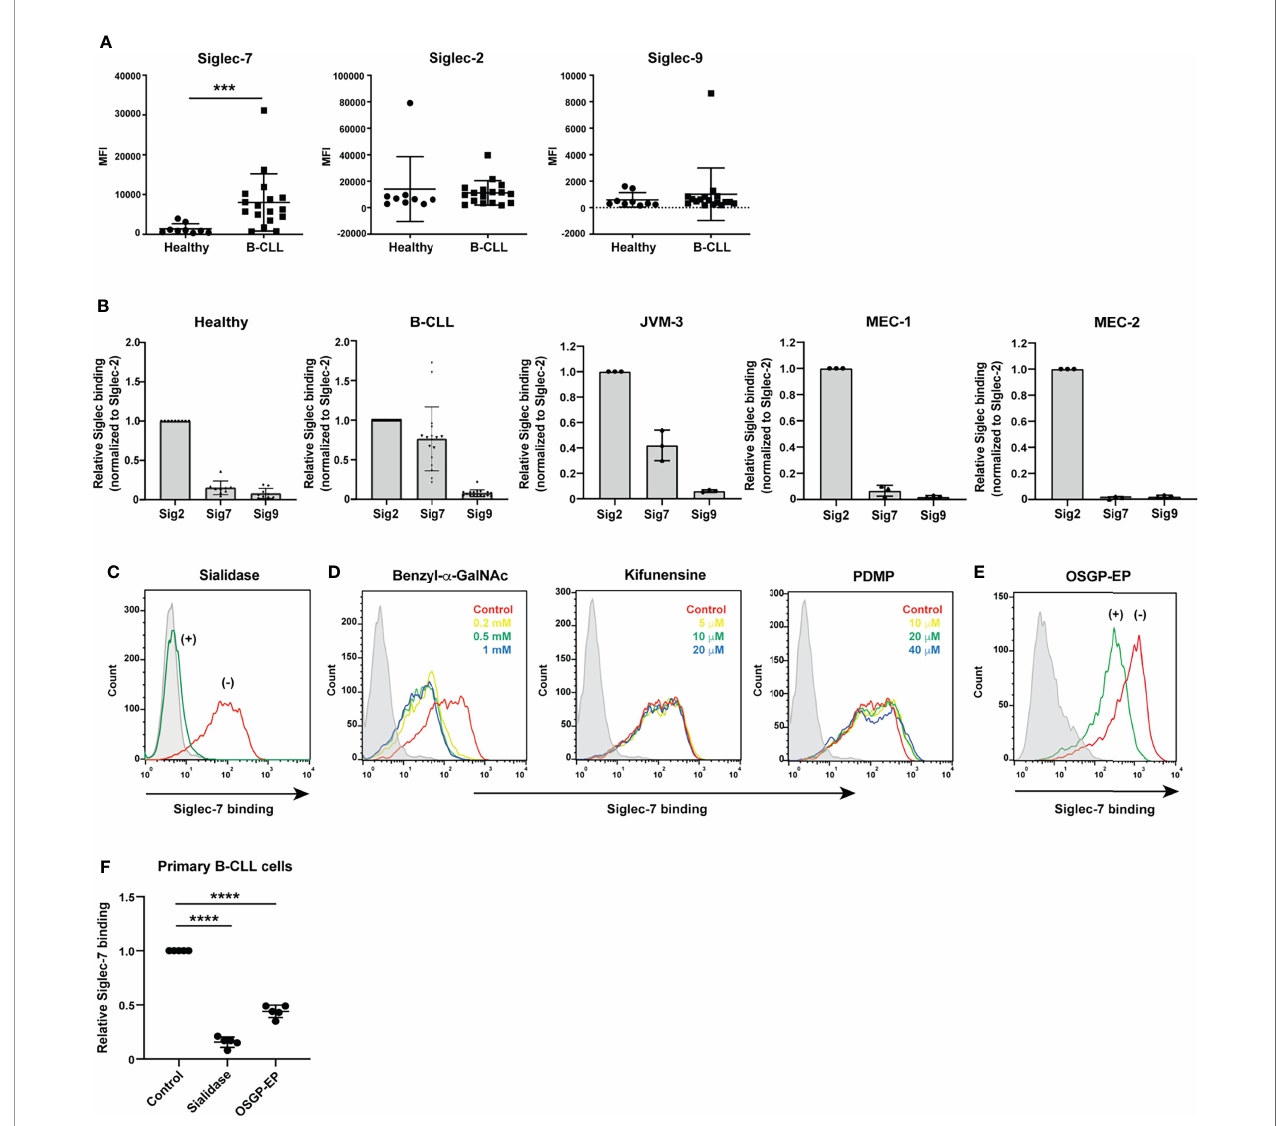
FIGURE 1 | Siglec-7 ligands are highly expressed on B cells from patients with chronic lymphocytic leukemia (CLL). (A) Comparison of Siglec ligand levels between B cells from healthy donors and those from CLL patients. The difference in Siglec-7 – Fc binding (expressed as median fl uorescence intensity [MFI]) to B cells between healthy donors (n = 9) and CLL patients (n = 17) was statistically signi fi cant (*** P < 0.001, Mann – Whitney test), whereas the difference in CD22/ Siglec-2 – Fc and Siglec-9 – Fc binding between the two groups was not ( P = 0.33 and 0.38, respectively; Mann – Whitney test). Bars represent mean ± SD. (B) Siglec ligands in primary B cells and CLL B cell lines. JVM-3, MEC-1, and MEC-2 cells were stained with recombinant CD22/Siglec-2 – Fc, Siglec-7 – Fc, and Siglec-9 – Fc and analyzed with fl ow cytometry. Siglec – Fc binding signals (in MFI) were normalized to that of CD22/Siglec-2 – Fc. Bars represent mean ± SD of three independent experiments. For primary B cells, the data was normalized individually for each donor [healthy donors (n = 9) and CLL patients (n = 17)], using the same dataset as presented in panel (A) . JVM-3 most closely resembled CLL B cells in terms of Siglec binding pattern. (C) Effect of sialidase treatment on Siglec-7 binding to JVM-3. JVM-3 cells were treated with (green) or without (red) sialidase before probing with recombinant Siglec-7 – Fc. Siglec-7 – Fc binding was abrogated by treatment of the cells with sialidase. Siglec-7(R124A) – Fc was used as a negative control (gray). (D) Effects of glycan processing inhibitors on Siglec-7 – Fc binding to JVM-3. Cells were cultured in the presence of benzyl-2-acetamido-2-deoxy- a - D -galactopyranoside (benzyl- a -GalNAc; red: control; yellow: 0.2 mM; green: 0.5 mM; blue: 1 mM), kifunensine (red: control; yellow: 5 m M; green: 10 m M; blue: 20 m M), or DL -threo-1-phenyl-2-decanoylamino-3- morpholino-1-propanol (PDMP; red: control; yellow: 10 m M; green: 20 m M; blue: 40 m M) for 72 h; stained with recombinant Siglec-7 – Fc; and analyzed with fl ow cytometry. Benzyl- a -GalNAc pretreatment attenuated Siglec-7 – Fc binding, whereas neither kifunensine nor PDMP did, implying that O-glycans exhibit the glycan epitope (glycotope) recognized by Siglec-7. (E) Effect of O-sialoglycoprotein endopeptidase (OSGP-EP) treatment on Siglec-7 – Fc binding to JVM-3. JVM-3 cells were treated with (green) or without (red) OSGP-EP before probing with recombinant Siglec-7 – Fc. OSGP-EP treatment of JVM-3 cells attenuated Siglec-7 – Fc binding, indicating that glycoproteins heavily modi fi ed by sialylated O-glycans (sialomucins) are the major ligands for Siglec-7. (F) Effect of enzyme treatment on Siglec-7 – Fc binding to B cells from CLL patients (n = 5). Sialidase and OSGP-EP treatment of B cells from CLL patients diminished Siglec-7 – Fc binding (**** P < 0.0001, one-way ANOVA with Dunnett ’ s post hoc test). Bars represent mean ±